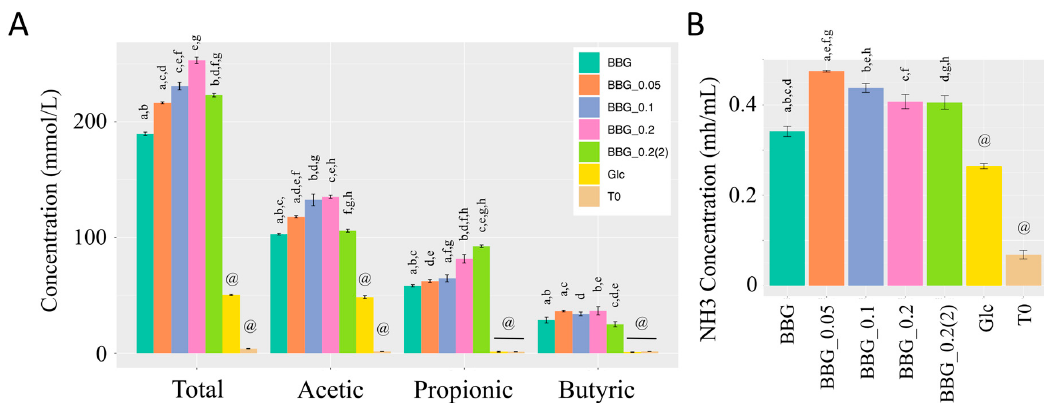
Figure 2. ( A ) Short chain fatty acid profiles and ( B ) ammonia concentration of the five BBG samples and glucose monomer. Different superscripts ( a–h ) represent significant difference by one-way